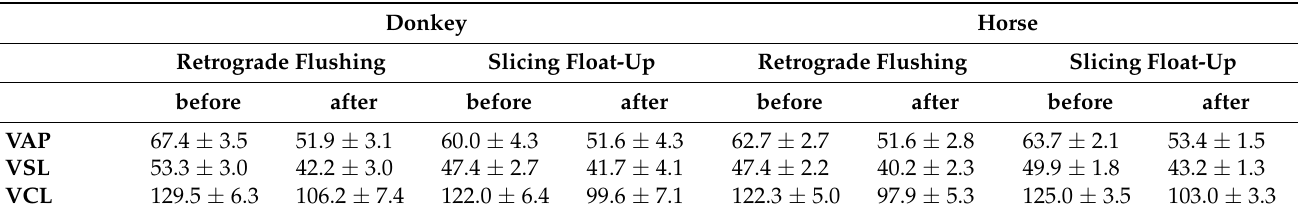
Table 2. Sperm kinematic parameters of donkey and horse epidydimal sperm harvested by retrograde flushing and slicing float-up before and after freezing.